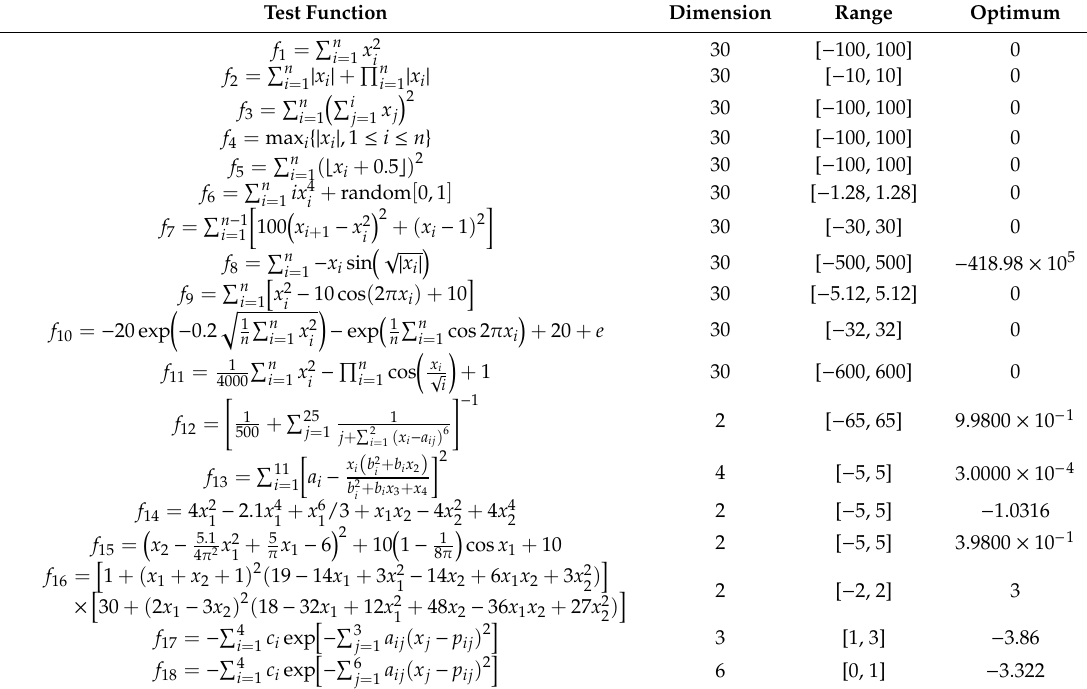
Table 1. The traditional benchmark problems used in investigation. Test Function Dimension